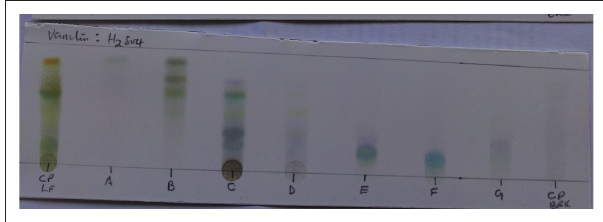
FIGURE 2: Comparison of chemical components present in leaves of Clausena anisata (Fractions A–G). Thin-layer chromatography plates were developed in hexane: EtOAC (2:1) and sprayed with vanillin–sulphuric